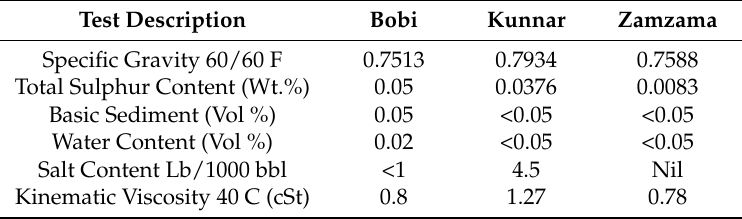
Figure 3. TBP Curves for the three Pakistani Crude Oils generated through Aspen HYSYS. Hot crude from the furnace and the pre-flash vapor from the pre-flash column were passed through the mixer and then introduced at the tray 28 of the column. Three side-strippers, each of